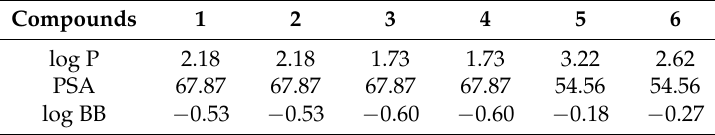
Table 6. The log P, PSA and calculated log BB values of compounds 1 – 6 .